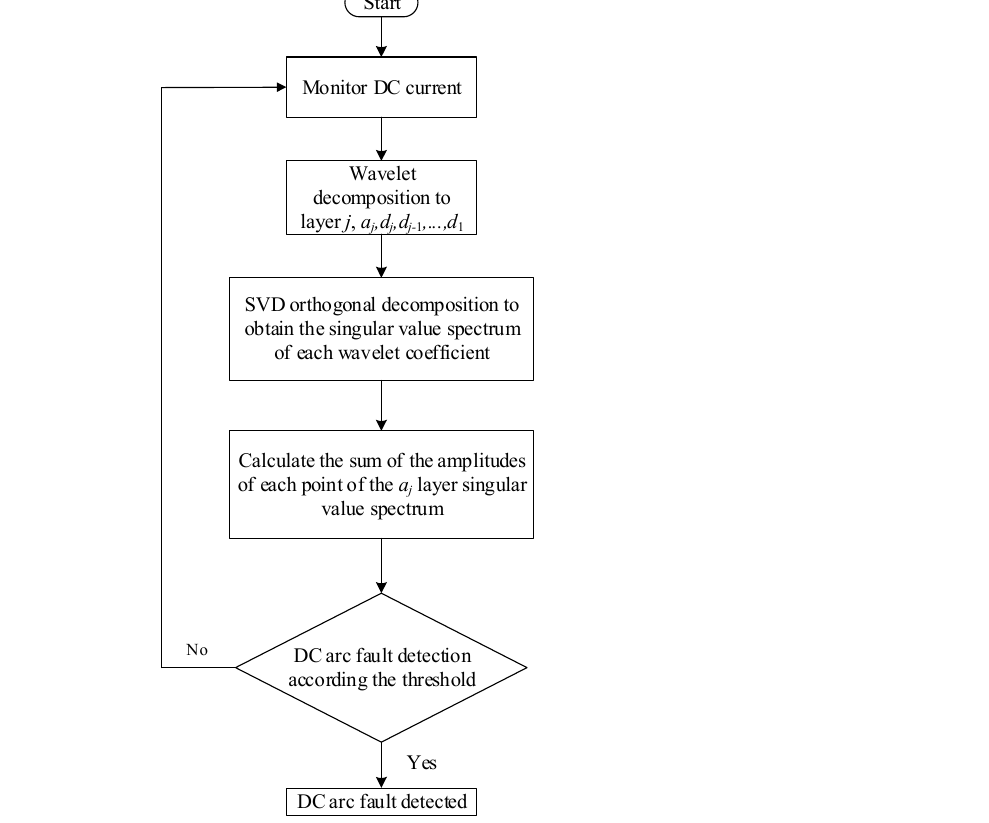
Figure 4. Flow chart of arc resistance detection.